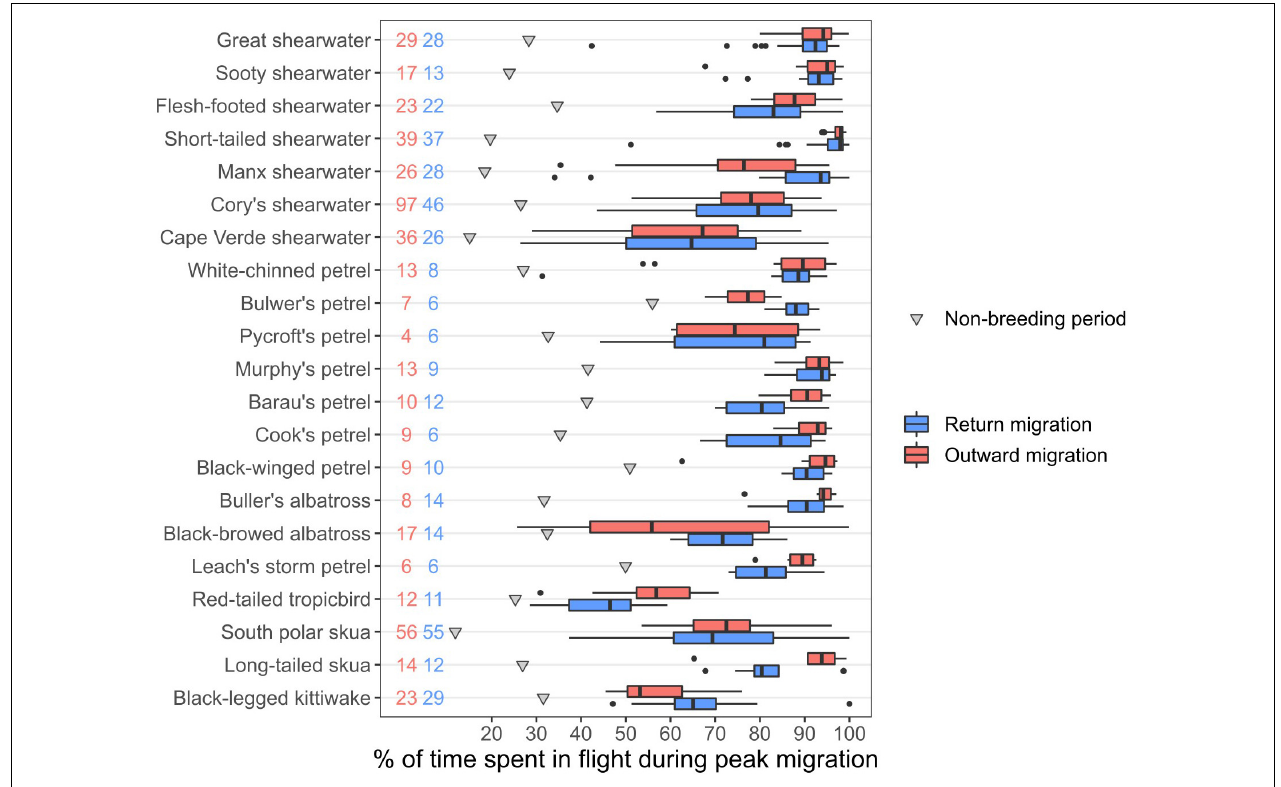
FIGURE 3 | Percentage of time spent in flight during the three consecutive days with the highest flight activity for each individual, aggregated by species. Pink: outward migration, blue: return migration, grey triangles: average flight time during the non-breeding period, for reference. Black dots represent outliers of the boxplots. Numbers represent sample sizes (pink: outward migration, blue: return migration).